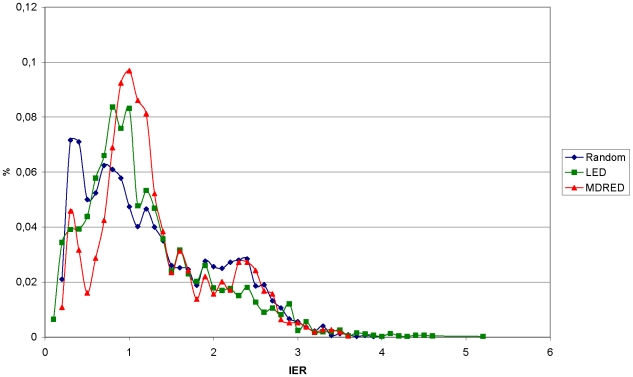
Comparison of protein distribution according to IER size.Protein numbers are displayed as percentages. Results from the α/β hydrolase database (LED) and the medium-chain dehydrogenase/reductase protein family (MDRED) are overlaid with results from the random set.